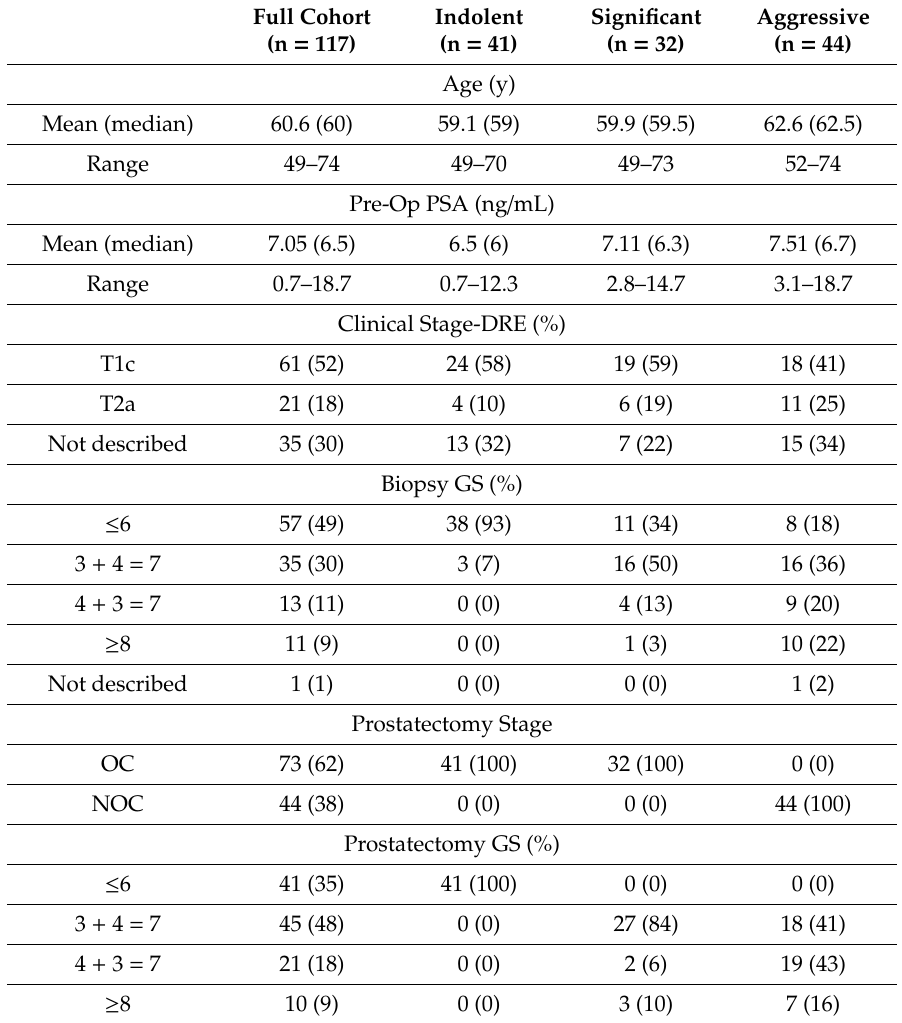
Table 1. Summary statistics for full cohort (n = 117), with breakdowns by indolent,